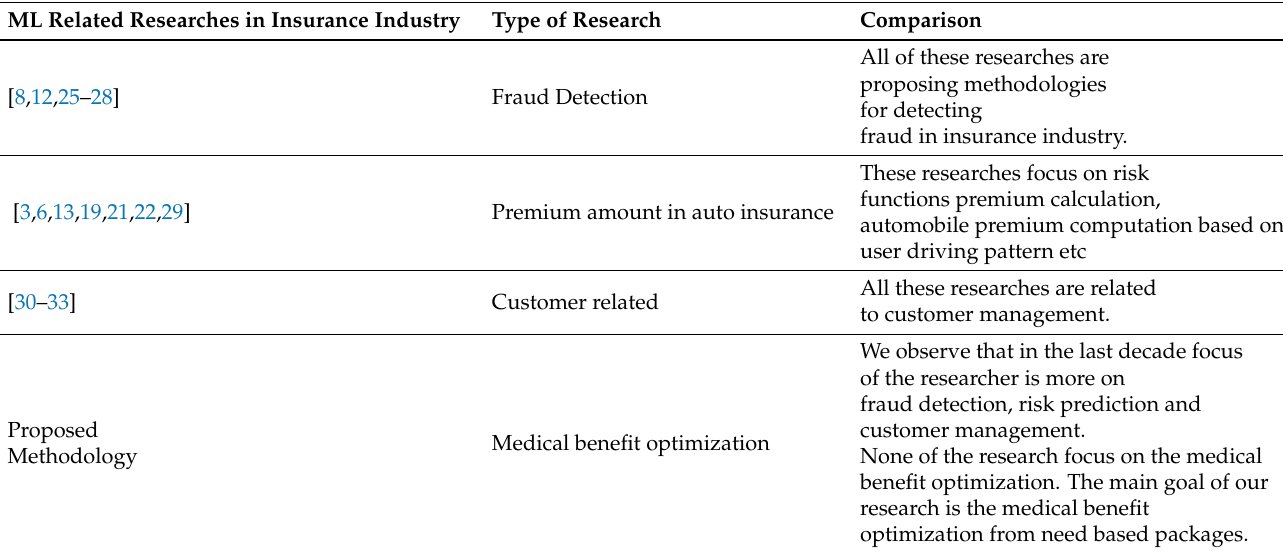
Table 20. Comparison with Existing